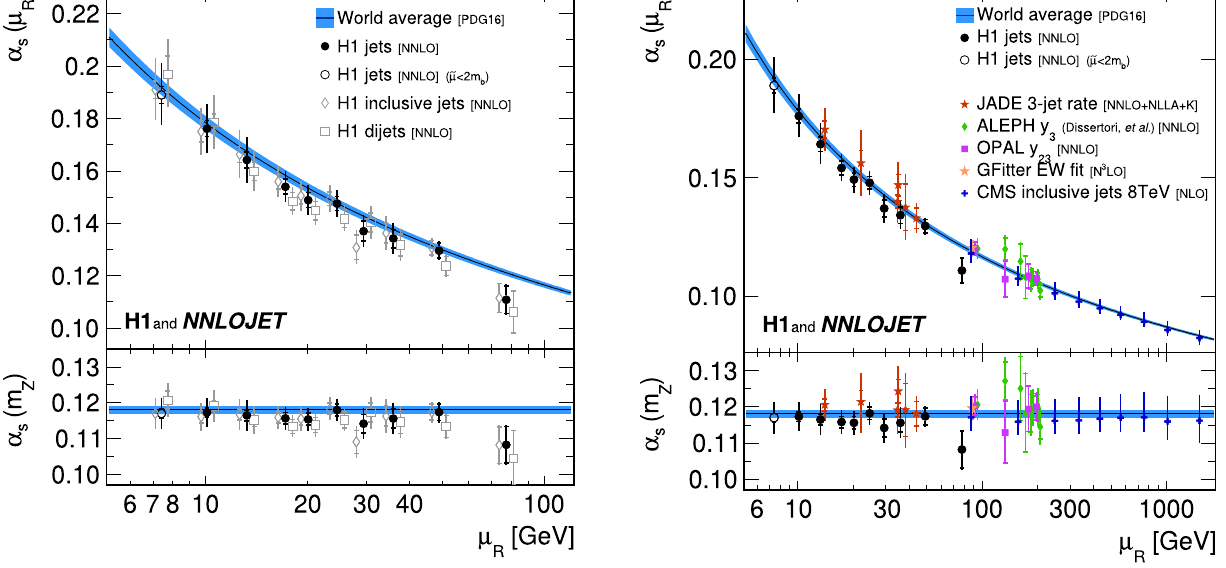
Fig. 14 Results for α s ( m Z ) and α s (μ R ) for fits to data points arranged in groups of similar μ R , compared to results from other experiments and processes. Further details can be found in the caption of Fig.